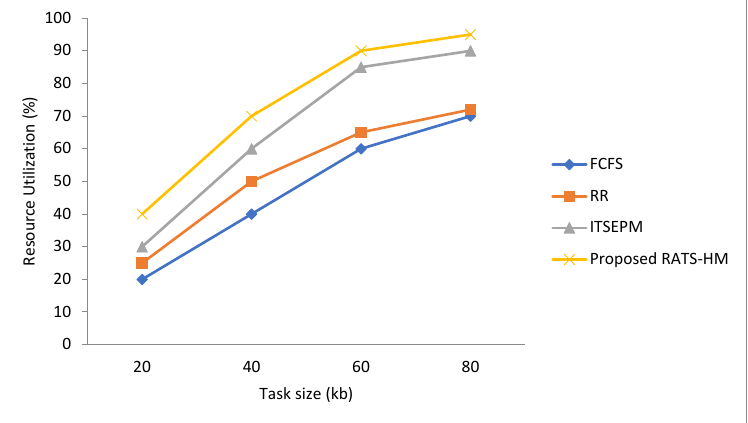
Figure 2. Resource utilization with proposed and existing techniques.